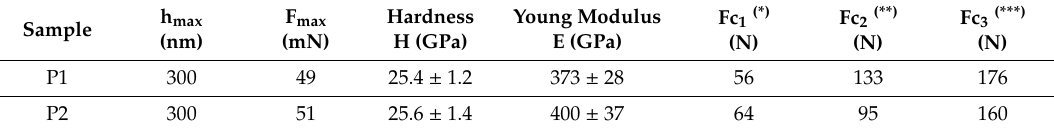
Table3. Hardness, YoungmodulusandvaluesofF C1 , F C2 andF C3 obtainedfortheinvestigatedcoatings.